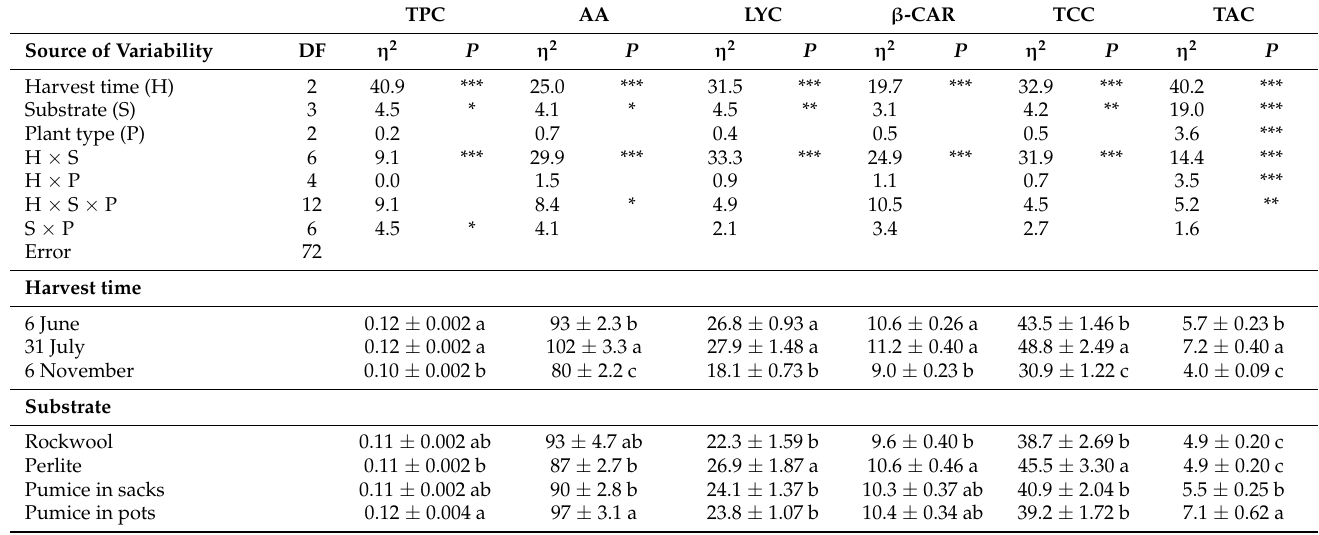
Table 3. Analysis of variance for average functional quality traits (total phenolic content: TPC, ascorbic acid: AA, lycopene: LYC, beta carotene: β -CAR, total carotenoid content: TCC, total antioxidant capacity: TAC) of tomato fruit harvested at three harvest dates (6 June, 31 July and 6 November). The fruit was obtained from self-rooted ‘Beef Bang F1’, ‘Beef Bang F1’ grafted onto ‘Defensor’, trained in single or double stem and grown hydroponically in four substrates (rockwool slabs, perlite in sacks, pumice in sacks and pumice in pots) in a